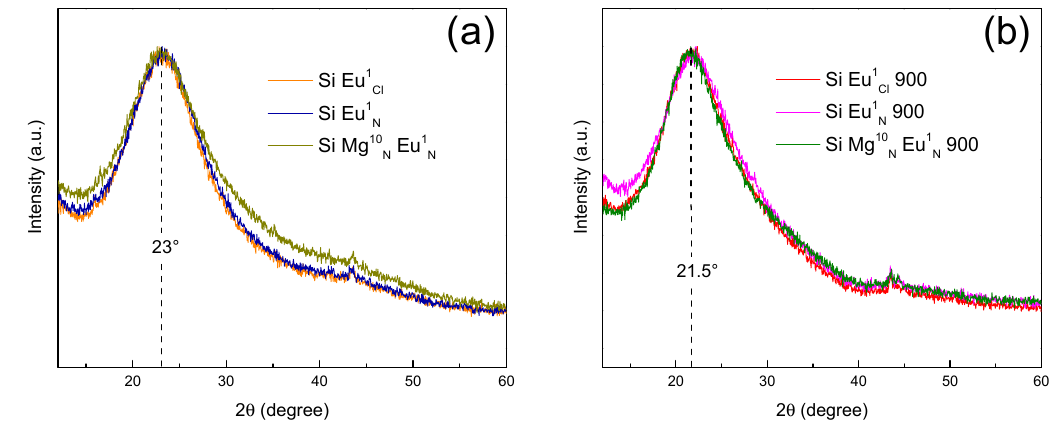
Eu 1 z ( b ) SiMg x Eu 1 z 900. N N